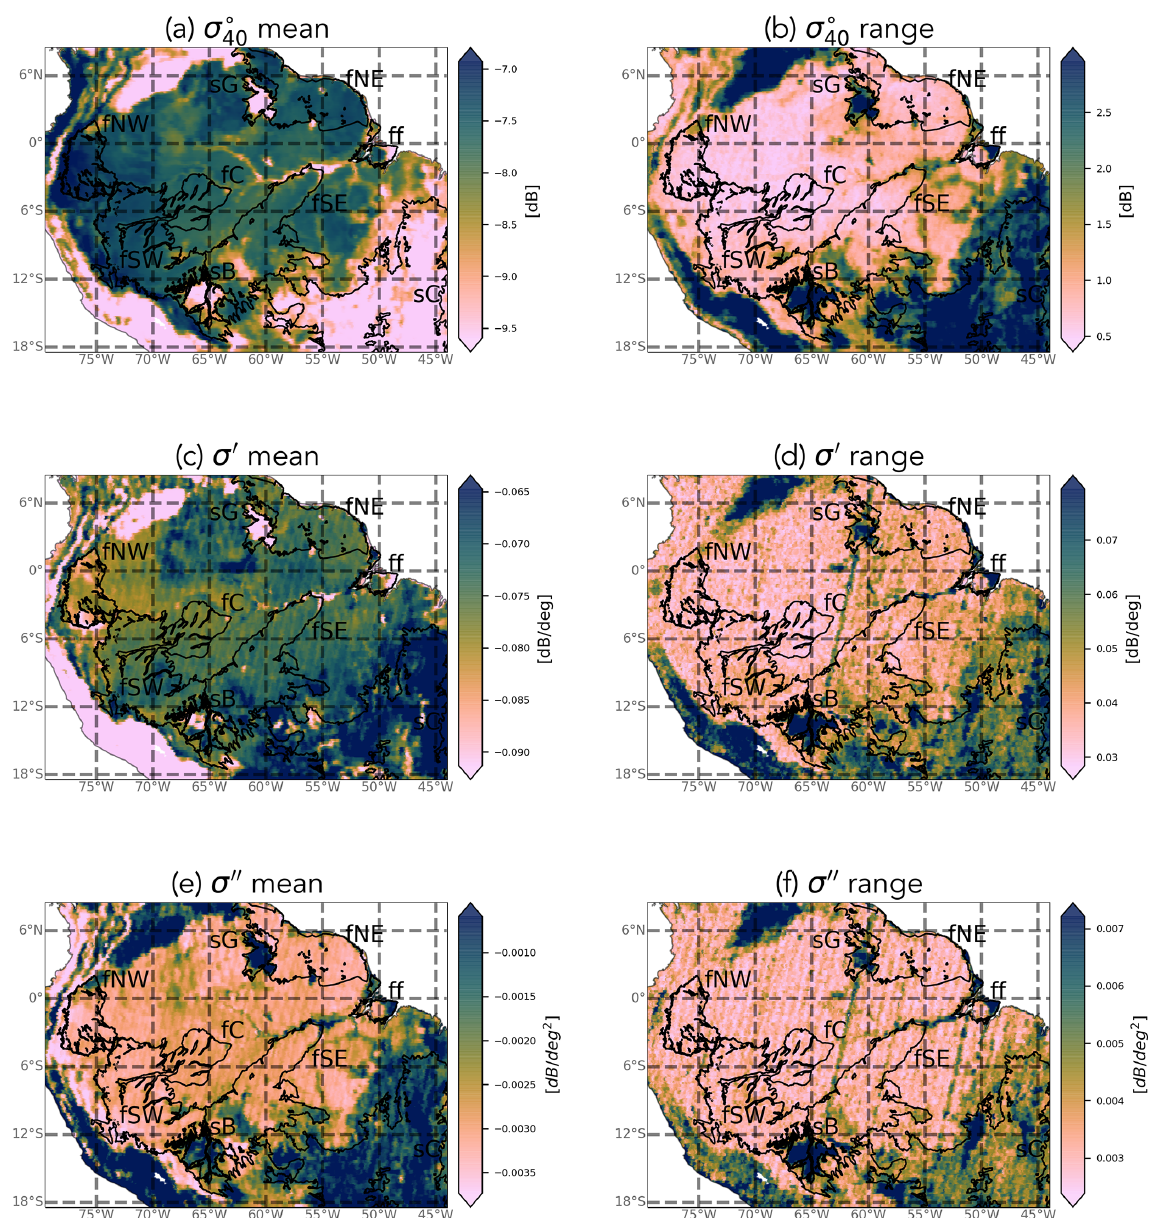
Figure 3. Mean and range of ASCAT normalized backscatter, slope, and curvature in the study period (2007–2016). Note that there are no data gaps, so white indicates that the quantity has a value equal to or less than the minimum value indicated on the color